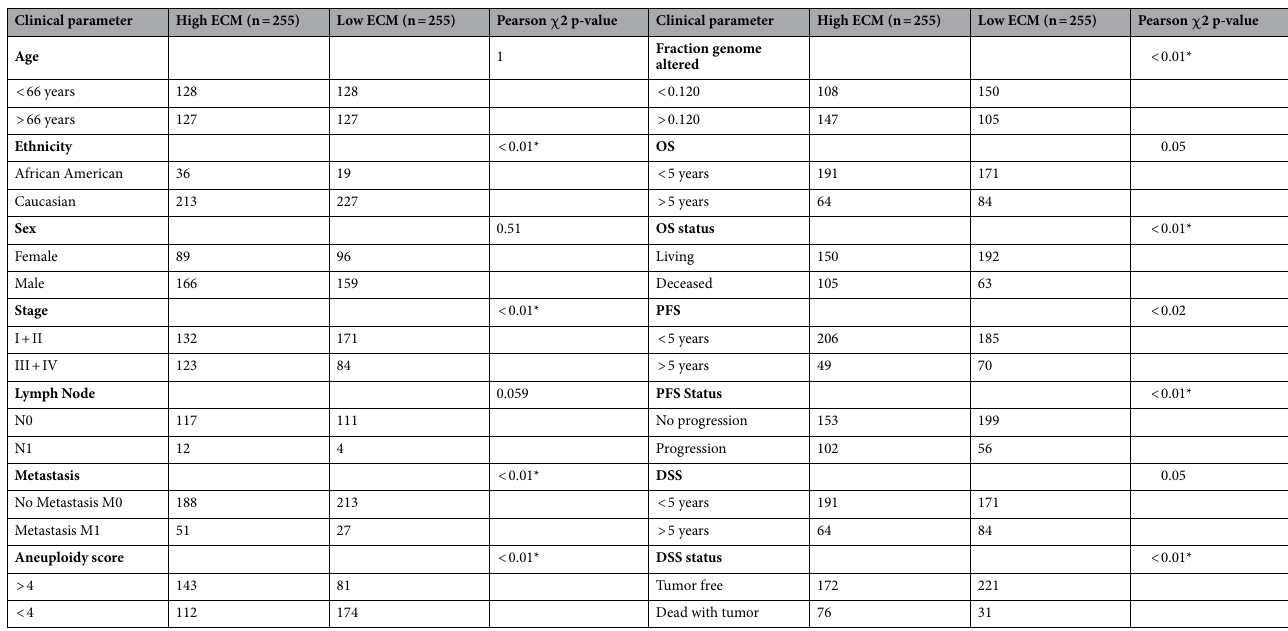
Table 2. Comparison of clinicopathological features of patients with enriched ECM and low ECM gene signature using Pearson’s chi-square analysis (TCGA-KIRC